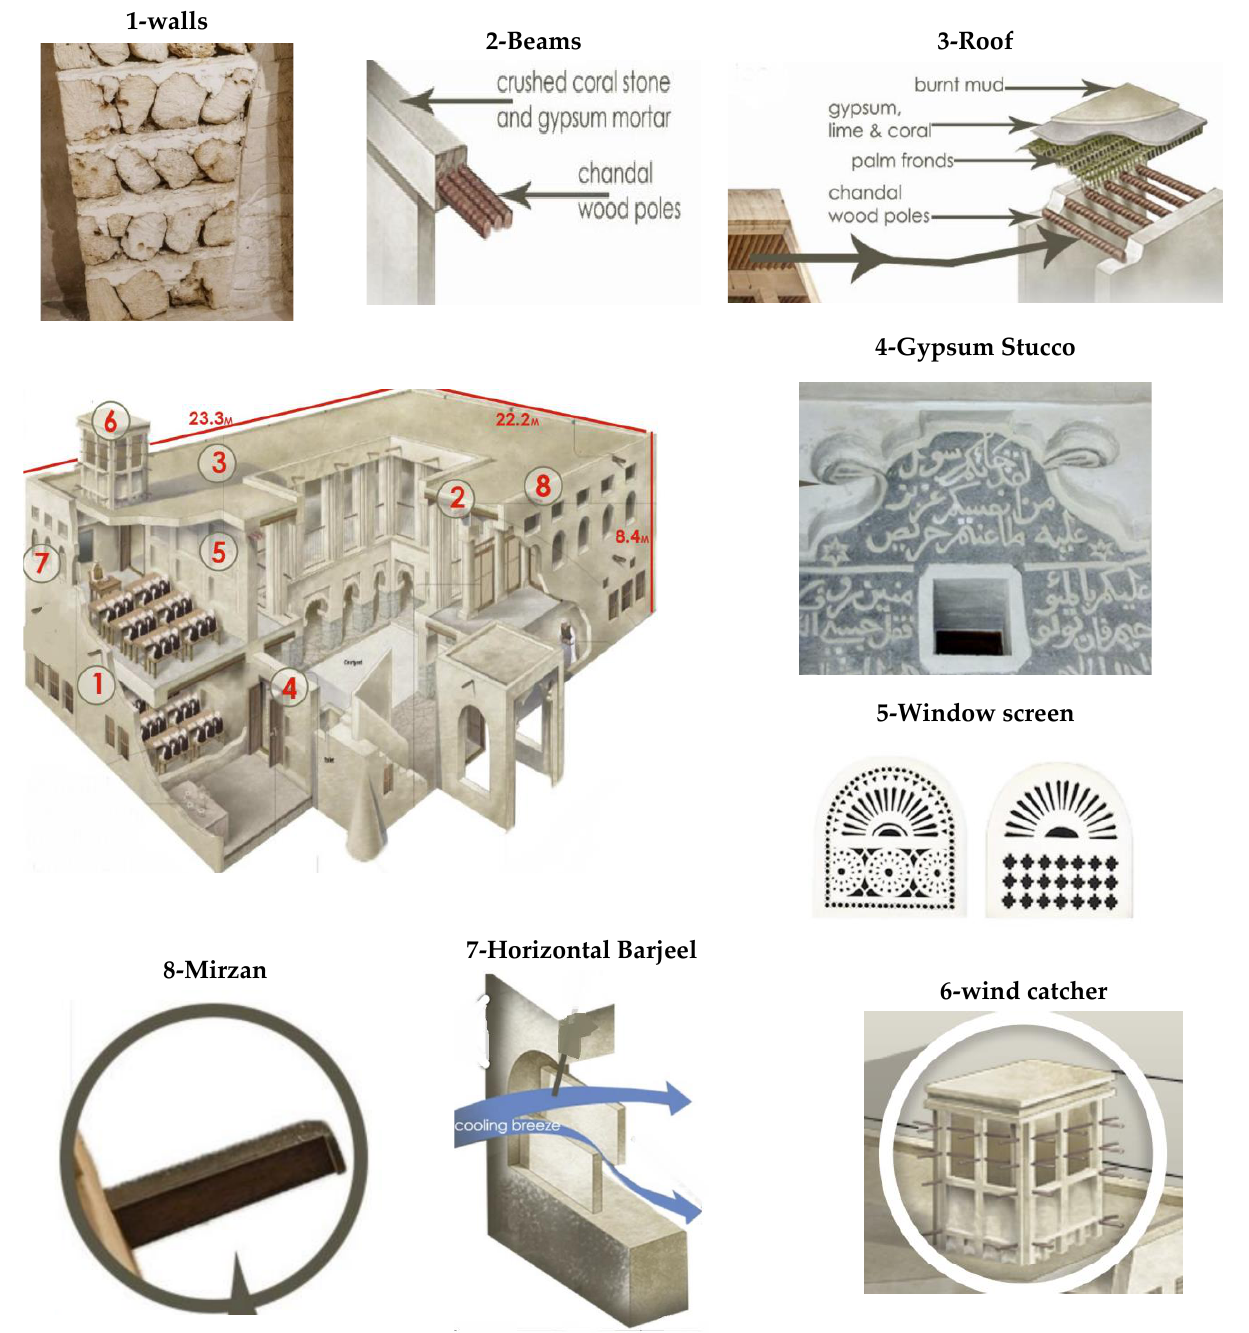
Figure 1. Architectural elements in Al Ahmadiya school, UAE [32,33].